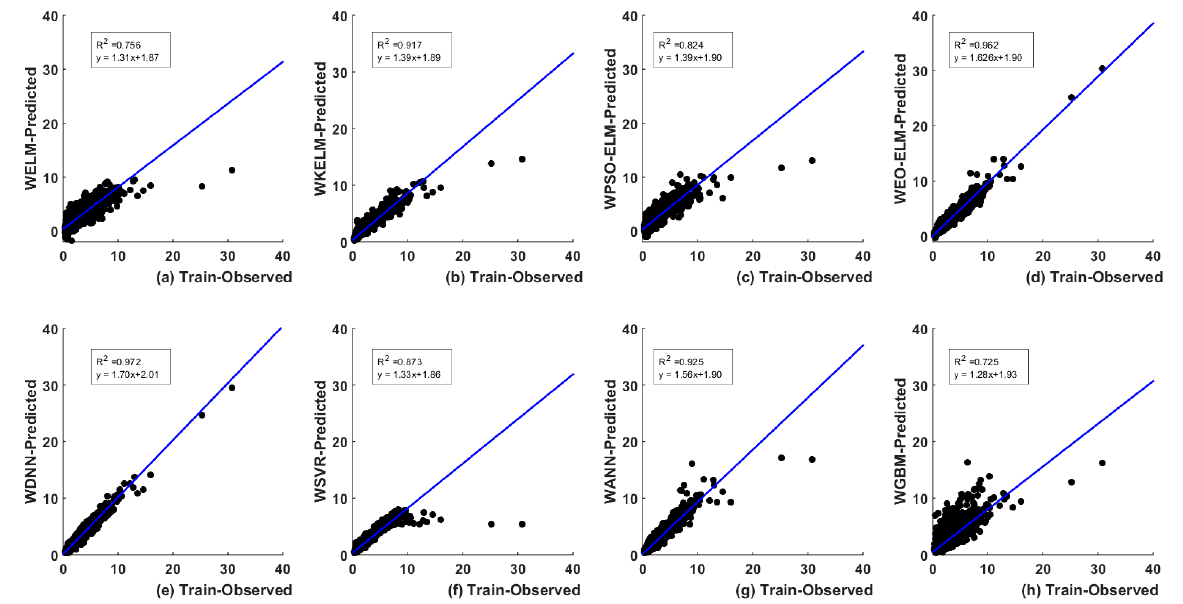
Figure 14. Prediction capability of the eight models in train case ( a ) WELM, ( b ) WKELM, ( c ) WPSO-ELM, ( d ) WEO-ELM, ( e ) WDNN, ( f ) WSVR, ( g ) WANN, and ( h ) WGBM for the catchment Fal at Tregony.